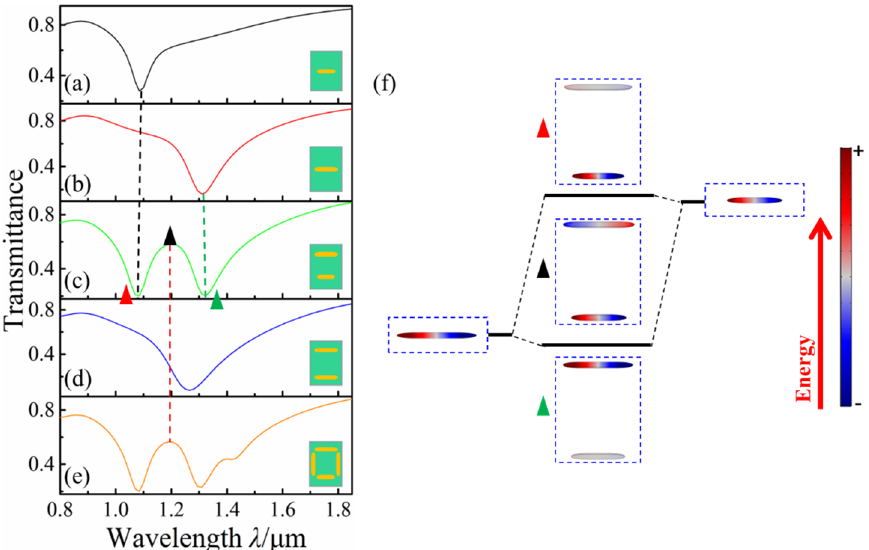
Figure 2d. Therefore, the asymmetrical profile composed of two transmission dips and a transmission peak is considered Fano resonance, which comes from the breaking symmetry of the horizontal double nanorods. To explain the physical mechanism of this process, the charge distributions and hybrid scheme of the horizontal top nanorod, the horizontal bottom nanorod, and asymmetric horizontal double nanorods are simulated and shown in Figure 2f. The solid black lines of different heights represent high and low energy in Figure 2f. The transmission dips of the horizontal top and bottom nanorods are caused by dipole oscillations, and the dipole of the horizontal top and bottom nanorod located in low and high energy state, respectively. The dipole vibration at the double transmission dips of the asymmetric horizontal double nanorods from the horizontal bottom and top nanorods, respectively. However, the two transmission dips of the asymmetric horizontal double nanorods are slightly shifted to shorter and longer wavelengths relative to the individual nanorods, respectively. At the same time, we also found that the antiphase charge oscillation is formed at the transmission peak of the asymmetric horizontal double nanorods as a result of the near-field interaction between the double nanorod dipole oscillations. Figure 2e shows the transmission spectra for the rectangular nanotetramer. The profiles of double Fano resonance are observed, and the resonance at the short wavelength corresponds with the asymmetric horizontal double nanorods, indicating that this resonance is due to the breaking symmetry of the horizontal double nanorods in the rectangular nanotetramer.